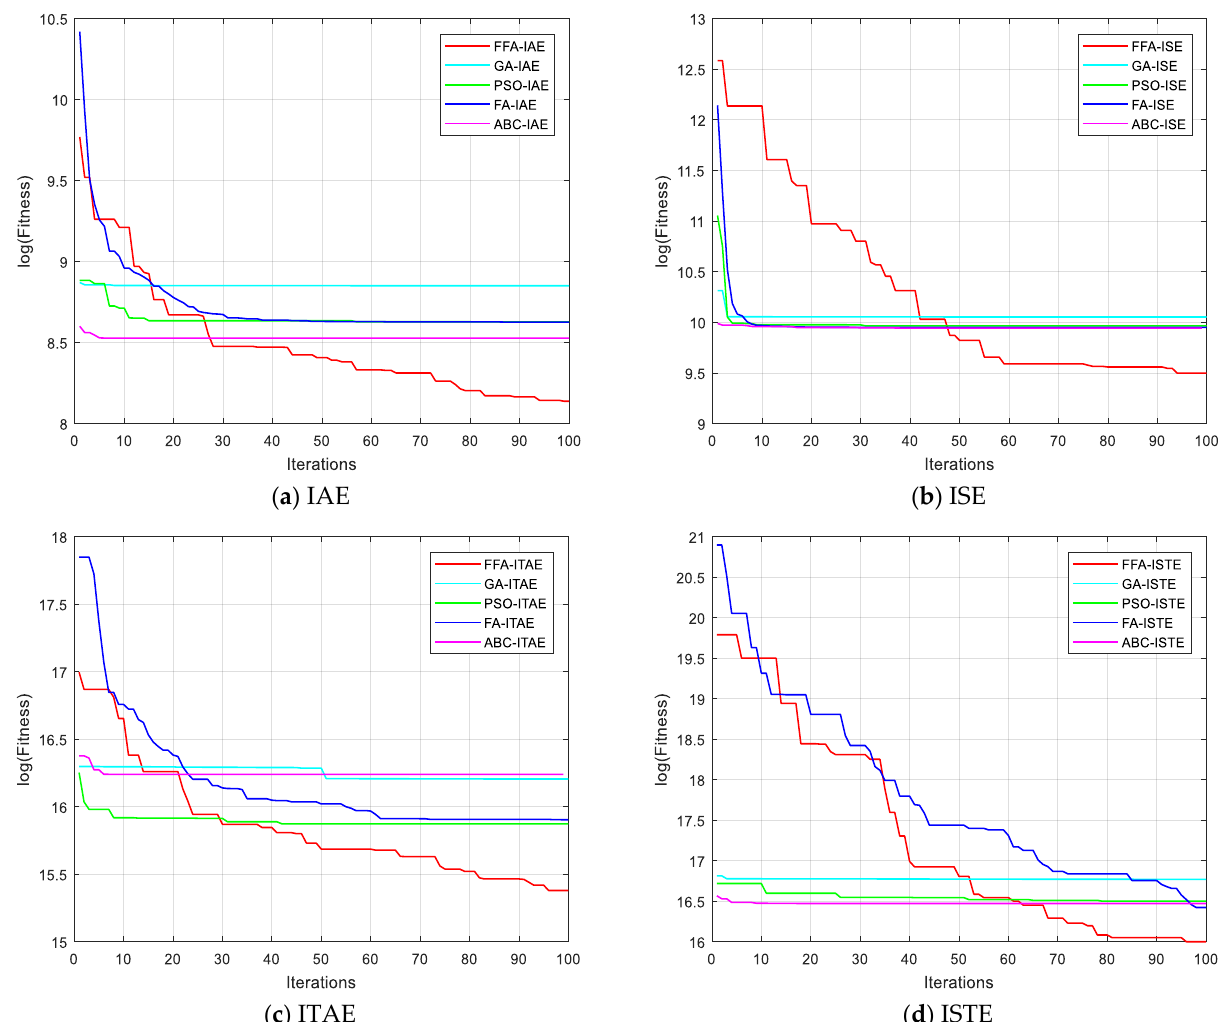
Figure 10. Convergence curves for different algorithms with several criteria.